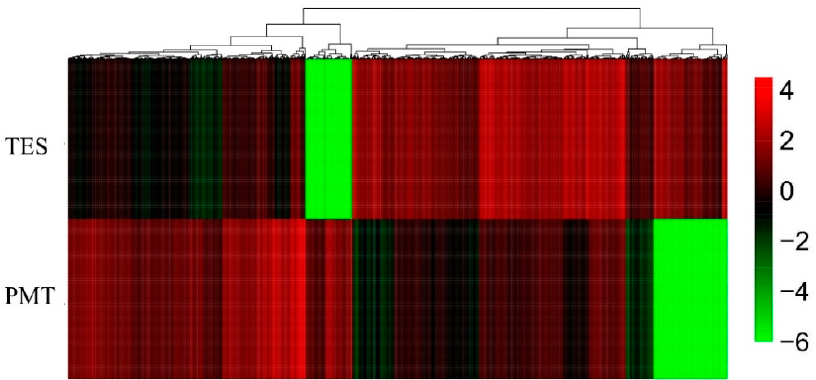
Figure 7. Hierarchical clustering of differentially expressed (DE) mRNAs among the TES and PMT. Heatmap of the count data for DE mRNA libraries for the DEGs identified between the TES and PMT.